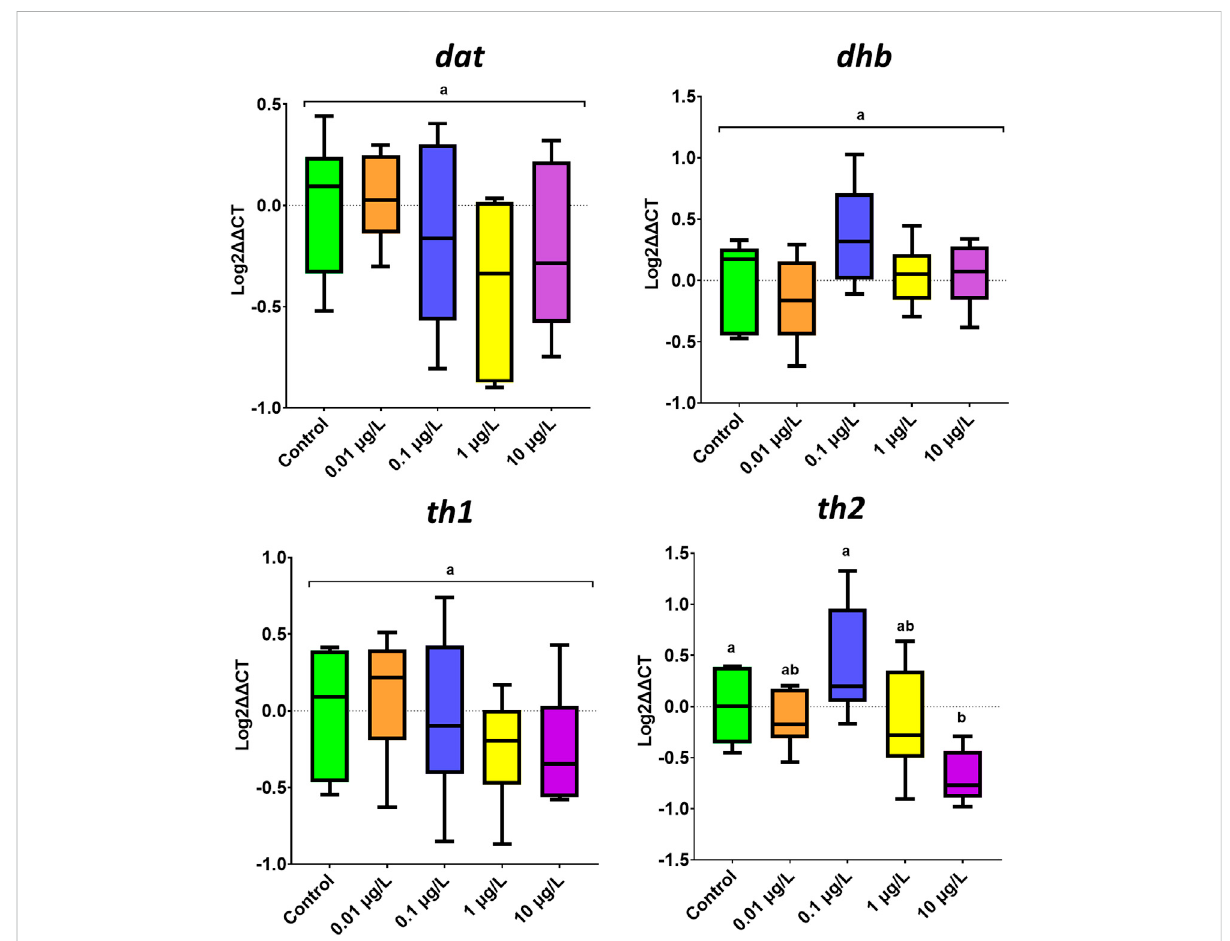
FIGURE 5 Expressionofgenesrelatedtothedopaminergicpathway inzebra fi shlarvaefollowingdevelopmental exposuretoSER.Resultsarerepresented as boxplots ( n = 6 – 8). Different letters represent different subset groups, following Tukey multiple comparison